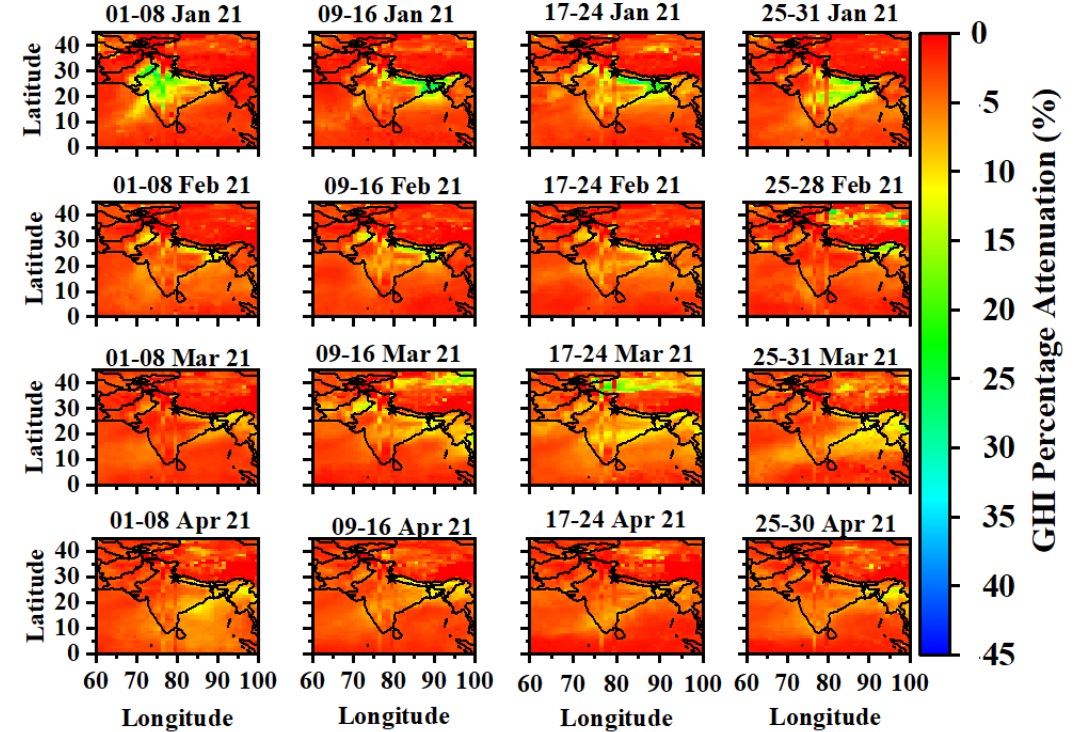
Figure 7. Weekly average maps of GHI percentage attenuation over the Indian subcontinent during the period of January to April 2021.